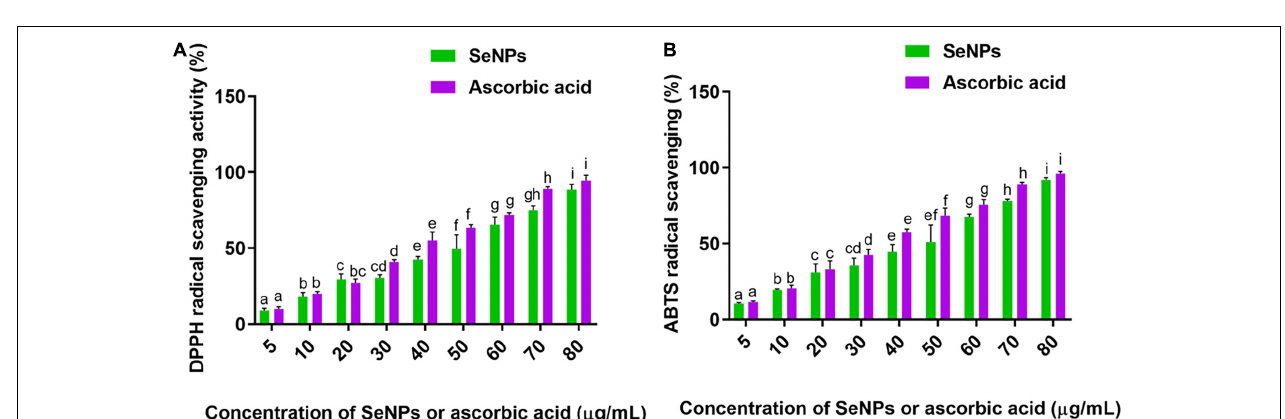
FIGURE 8 | (A) DPPH and (B) ABTS radicals scavenging potential of SeNPs in a dose-dependent manner. The experiments in the study were carried out three times, each time independently. The mean and SD of the triplicate research were calculated using the results from each experiment. The bar graphs with different letters within the particular analysis were significant ( p -value ≤ 0.05) by Tukey’s